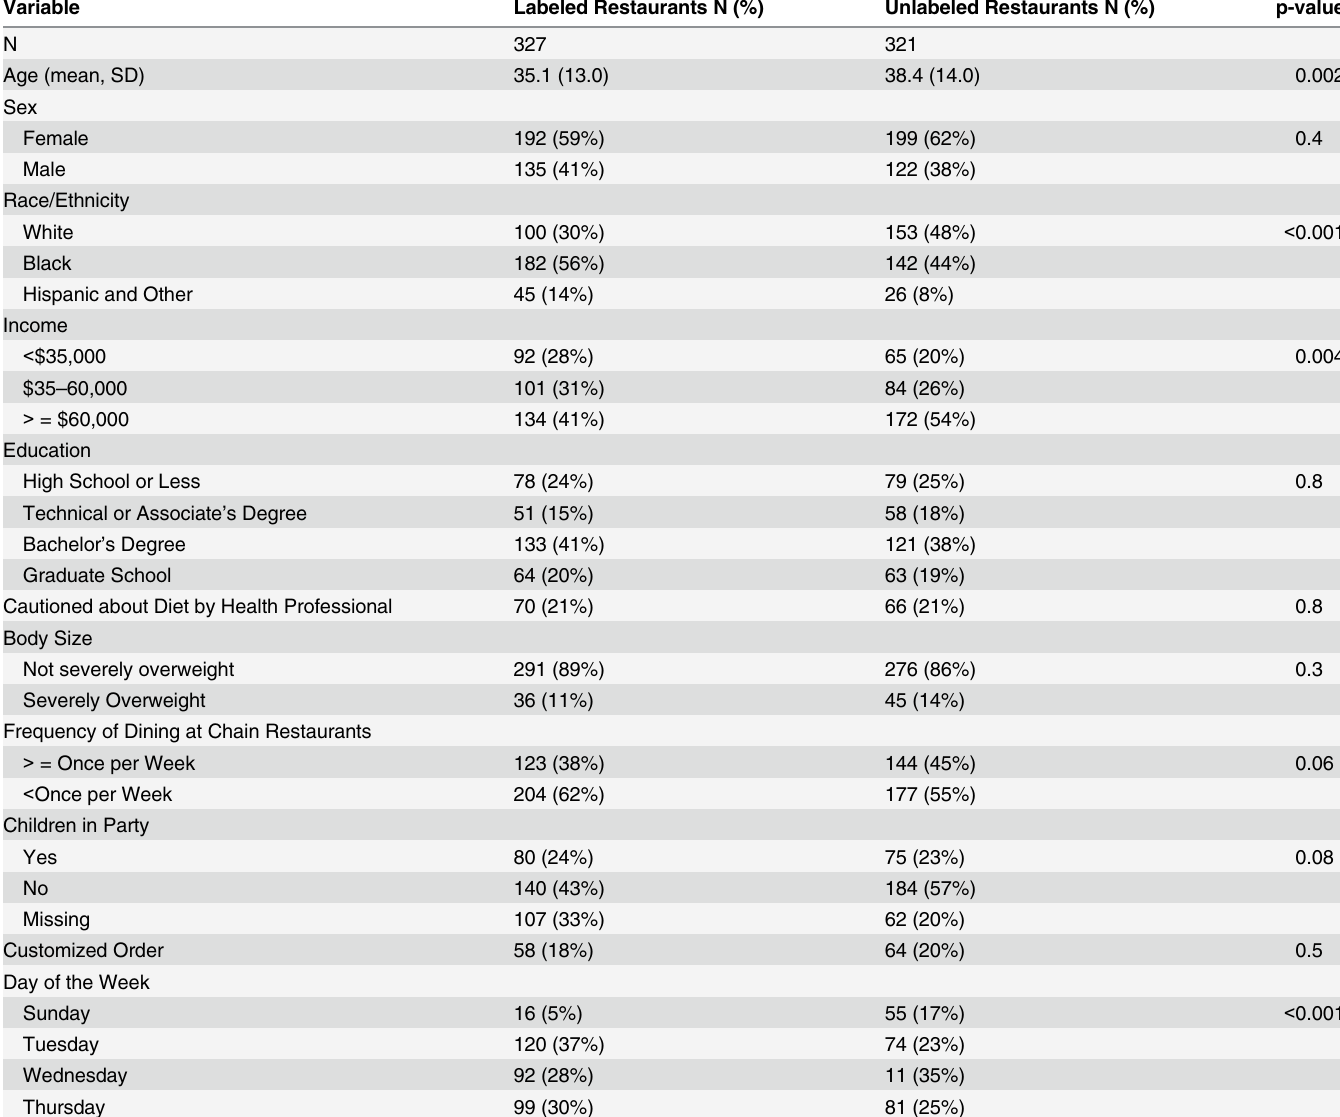
Table 1. Initial Covariate Balance between Treated (Labeled) and Control (Unlabeled) Restaurant